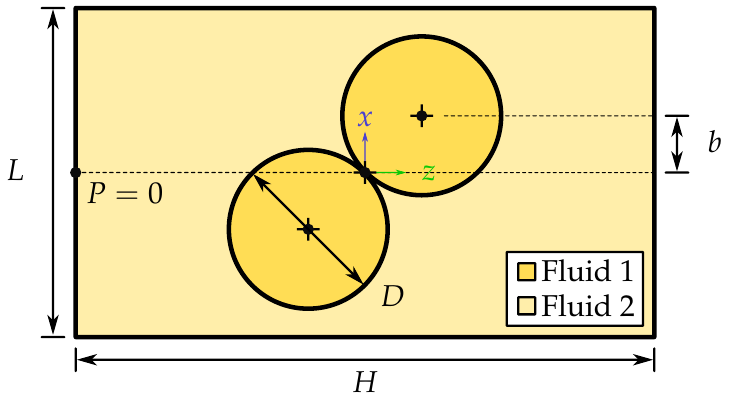
Figure 13. Schematic description of the colliding droplets case.